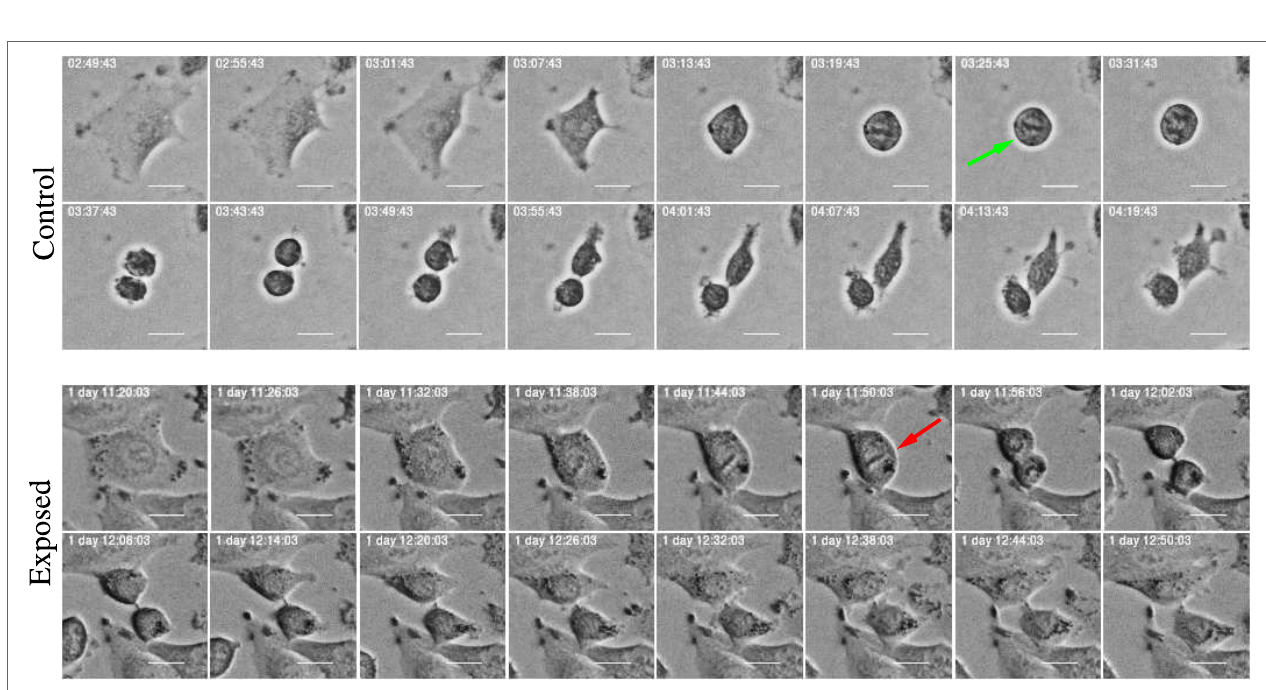
FigUre 14 | Comparison of life span for sister cells observed to be born and die bye necrosis and/or apoptosis during the observation period of about 94 h. The cells were exposed to YTX at concentrations 200, 500, and 1,000 nM. “Sister 1” denotes the one with the longest life span of two related sisters. Note that there are more mixed cell death modalities (green) for sister cells exposed to 1,000 nM YTX as compared exposure with the lower concentrations. Necrosis tends partly to appear later than apoptosis for exposure by 500 nM.